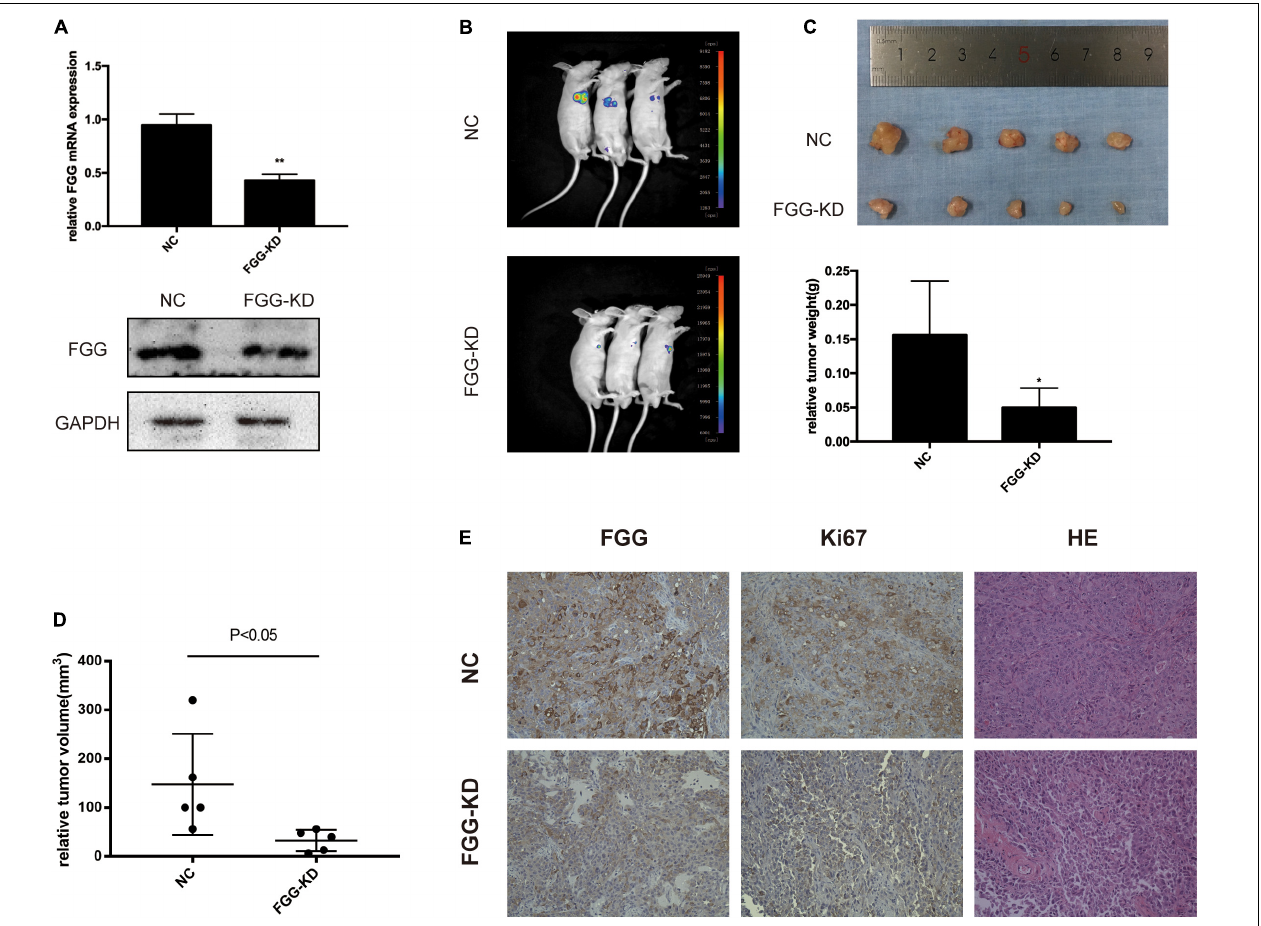
FIGURE 6 | FGG knockdown inhibits PCa cell proliferation in vivo . (A) The efficiency of the shRNA. (B) Bioluminescence images of the resultant DU145 tumors in the NC and FGG-KD groups. (C) Subcutaneous tumors were excised and weighed 4 weeks after inoculation. (D) Relative tumor volumes of the NC and FGG-KD groups. (E) Representative IHC and HE staining images of the NC and FGG-KD subcutaneous tumors. * p < 0.05, ** p <